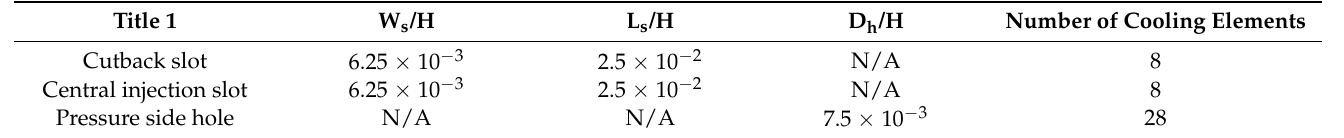
Table 1. Cooling scheme design parameters (normalized by the span length